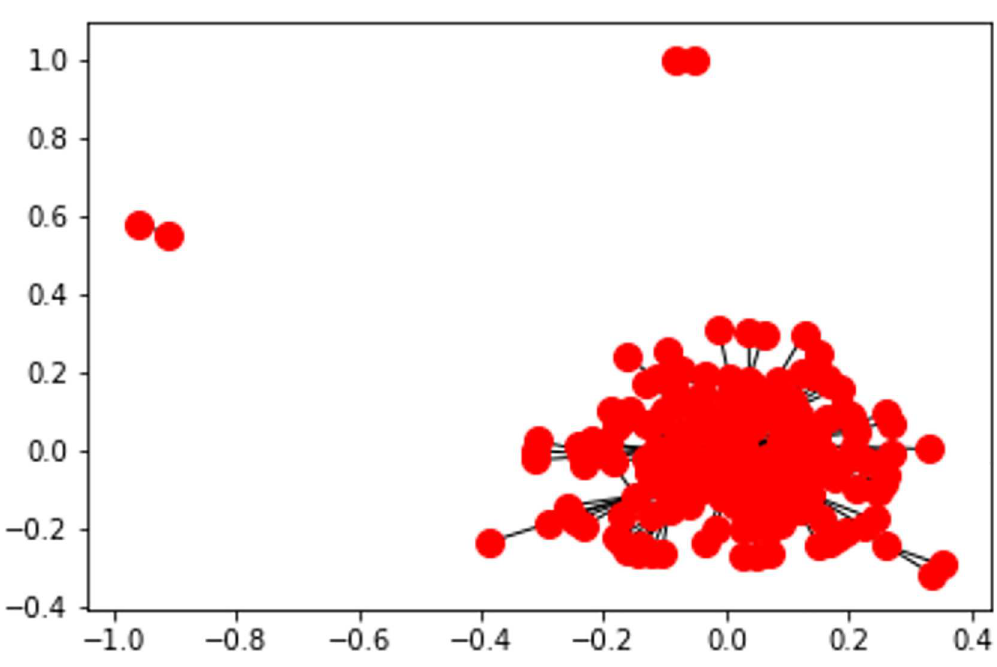
Fig 21. Station-polarity graph generation without edge embedding.